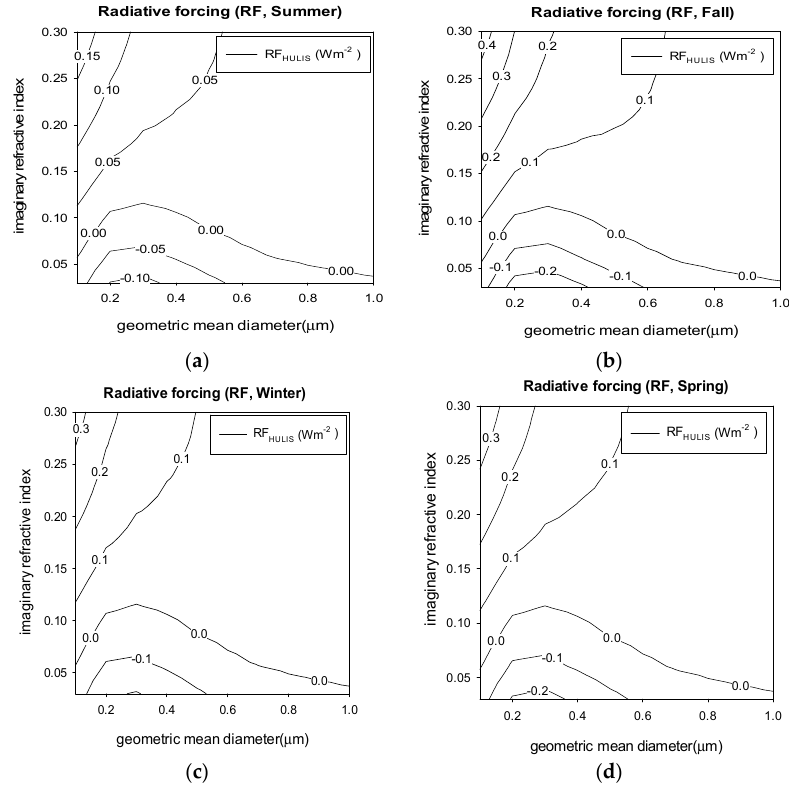
Figure 8. Contour plot of HULIS aerosol RF in the range of various geometric mean diameters and the IRI of HULIS aerosols (0.1 µ m < d g < 1.0 µ m, σ g = 1.5, 0.006 < HULIS IRI < 0.3) in ( a ) summer; ( b ) fall; ( c ) winter; and ( d )